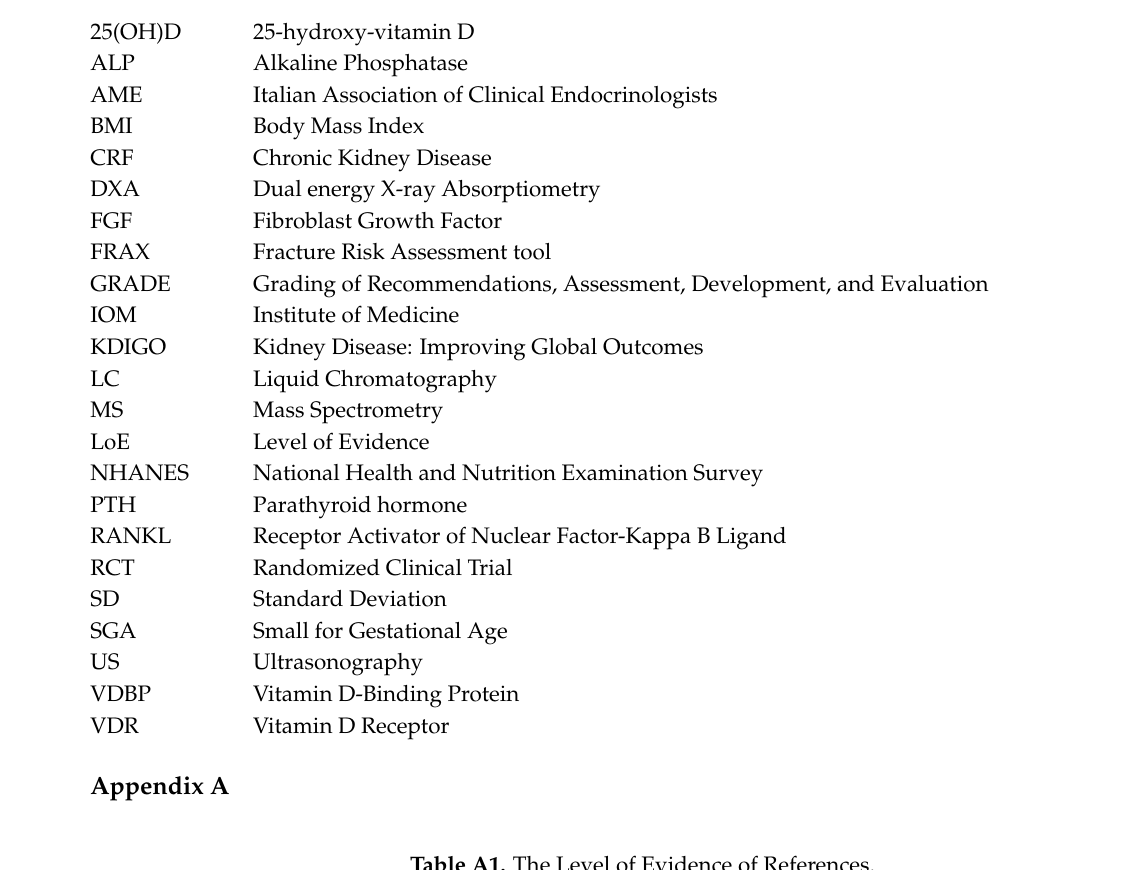
Table A1. The Level of Evidence of